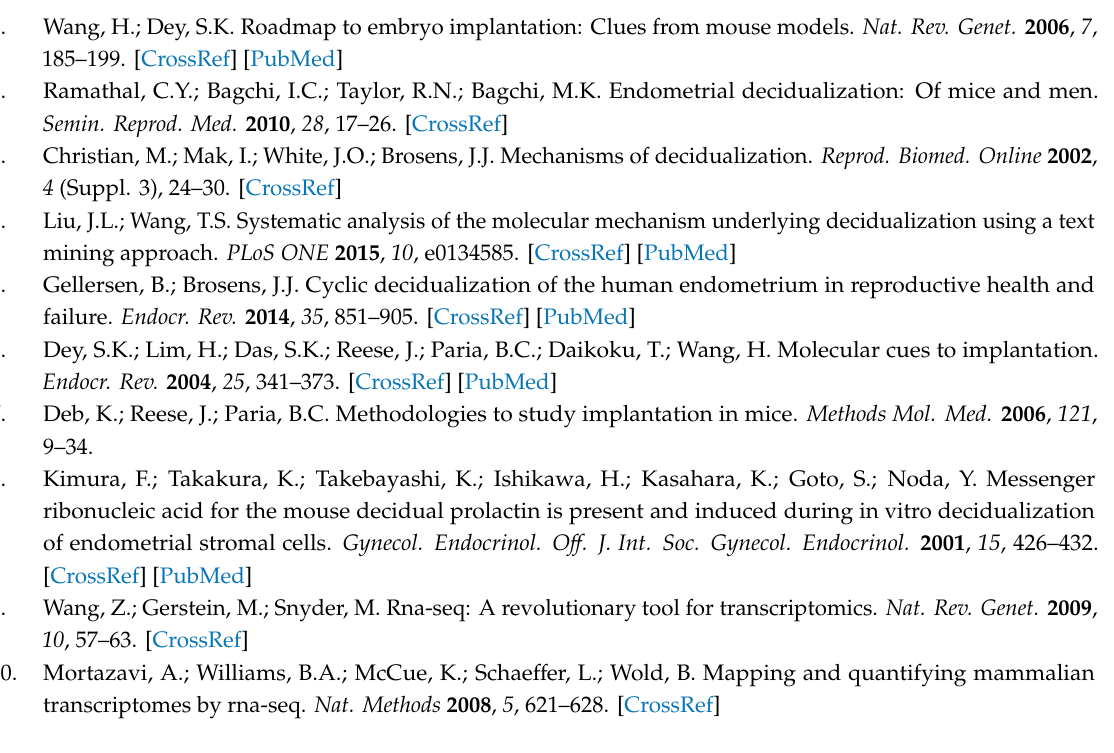
Figure S1: The expression of 4 decidualization marker genes in an alternative model of IVD with 0.5mM 8-Br-cAMP and 1 µ M MPA for 4 days, Table S1: Primers used in this study for quantitative RT-PCR analysis, Table S2: The complete list of di ff erentially expressed genes in natural pregnancy decidualization (NPD) (fold change > 2 and FDR < 0.01), Table S3: The complete list of di ff erentially expressed genes in artificial decidualization (AD) (fold change > 2 and FDR < 0.01), Table S4: A list of genes that were consistently expressed between NPD and AD, Table S5: A list of genes that were inconsistently expressed between NPD and AD, Table S6: The complete list of di ff erentially expressed genes in in vitro decidualization (IVD) (fold change > 2 and FDR < 0.01), Table S7: A list of genes that were consistently expressed between NPD and IVD, Table S8: A list of genes that were inconsistently expressed between NPD and